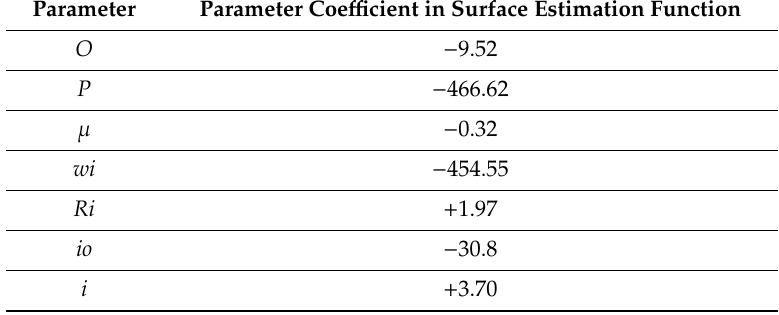
Table 2. The coe ffi cients of the parameters in the surface estimation function with a lower demand level and α = 0.1.